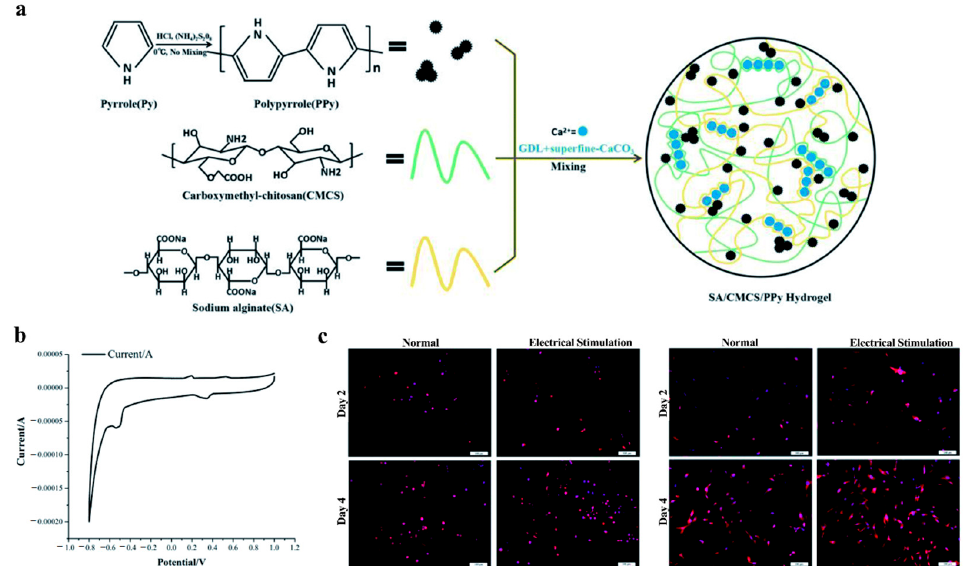
Figure 9. A conductive hydrogel doped with poly-pyrrole for peripheral nerve regeneration. ( a ) Preparation and structure of hydrogel; ( b ) cyclic voltammograms of the hydrogel; ( c ) repre- sentative fluorescence images RSC96 and BMMSC cells on hydrogels cultured for 2 and 4 days, and the electrical stimulation cell group stimulated with 100 mV for 2 h each 24 h. (Adapted with permission from Ref. [211]. 2018, Royal Society of